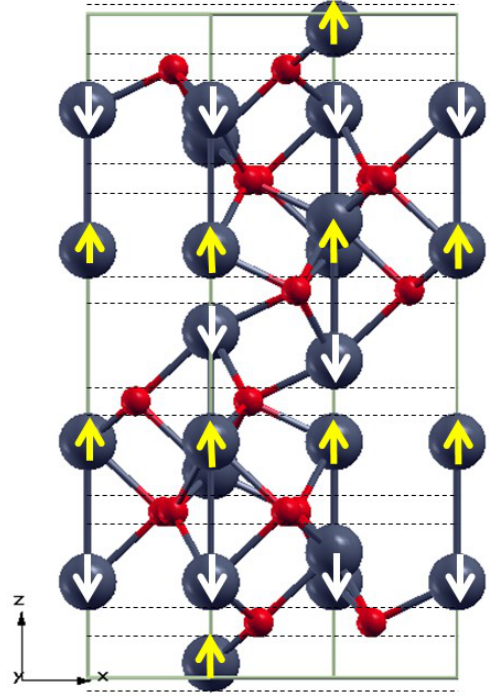
Figure 3. Hexagonal α-Fe O lattice with anti-ferromagnetic spin arrangements indicated by 2 3 up (yellow) and down (white) arrows at the Fe sites. Color scheme: Fe = grey and O =